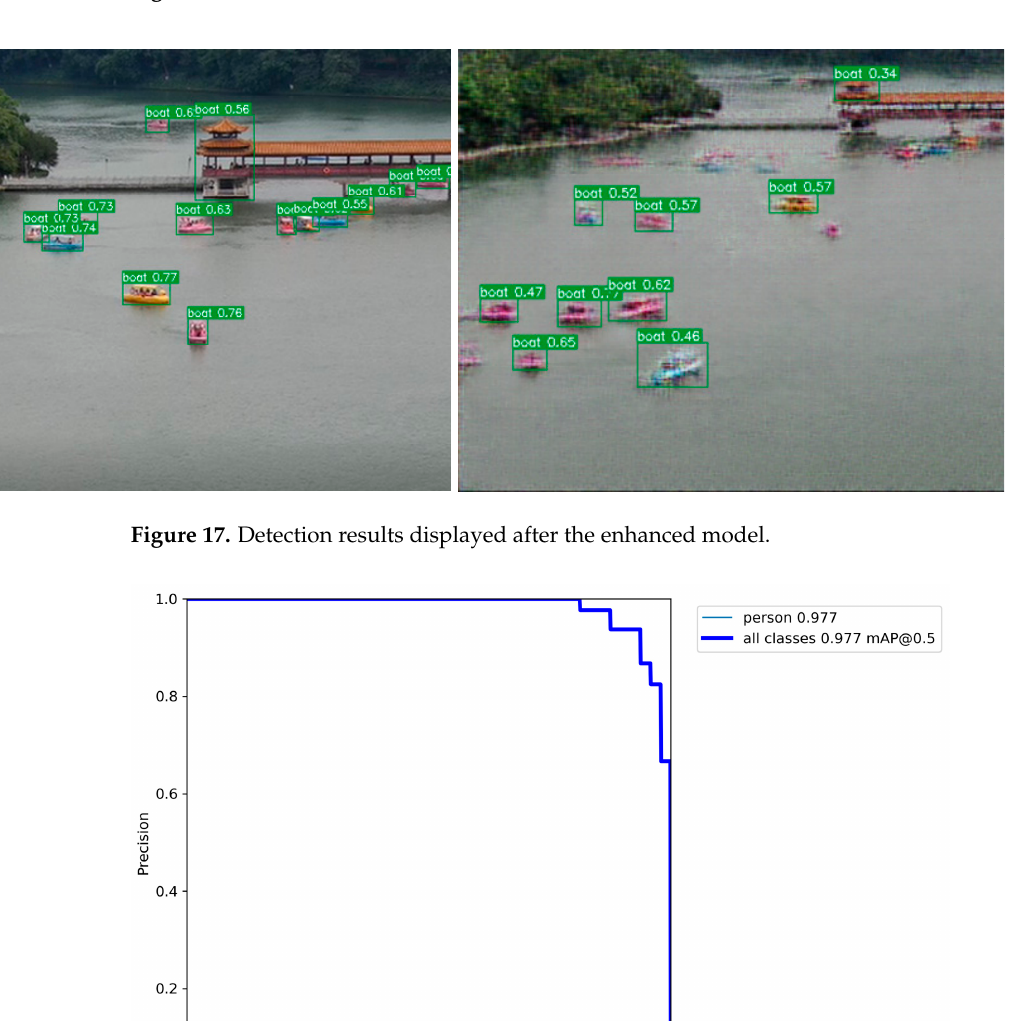
Figure 16. The fake dataset.